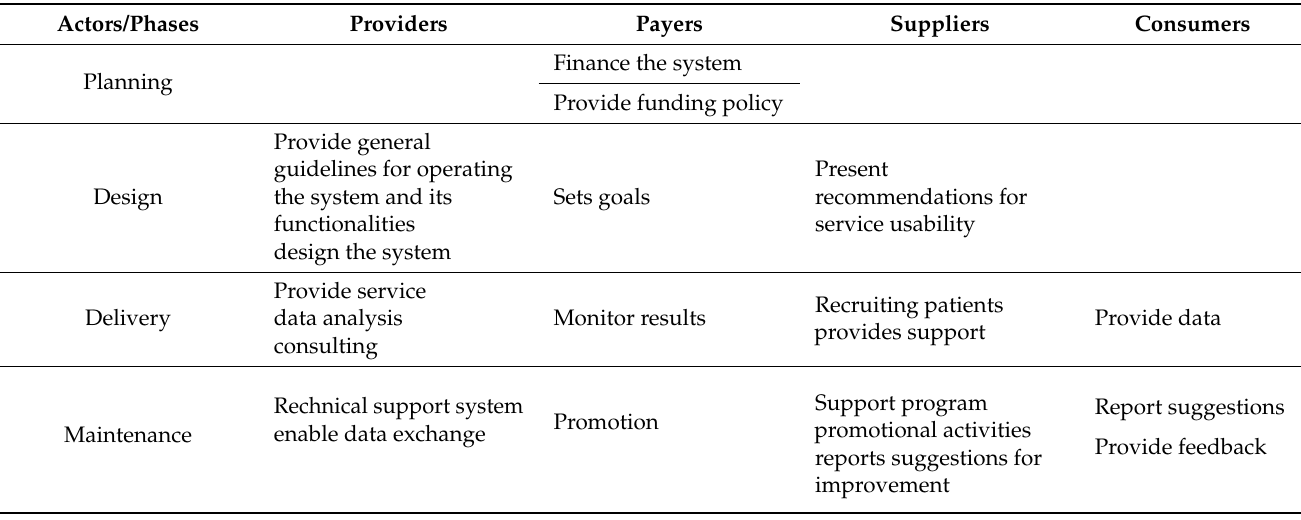
Table 7. Cocreation matrix for TeleAngel .